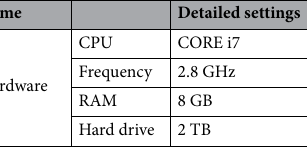
Table 3. Details of the utilized system in optimization process in the current